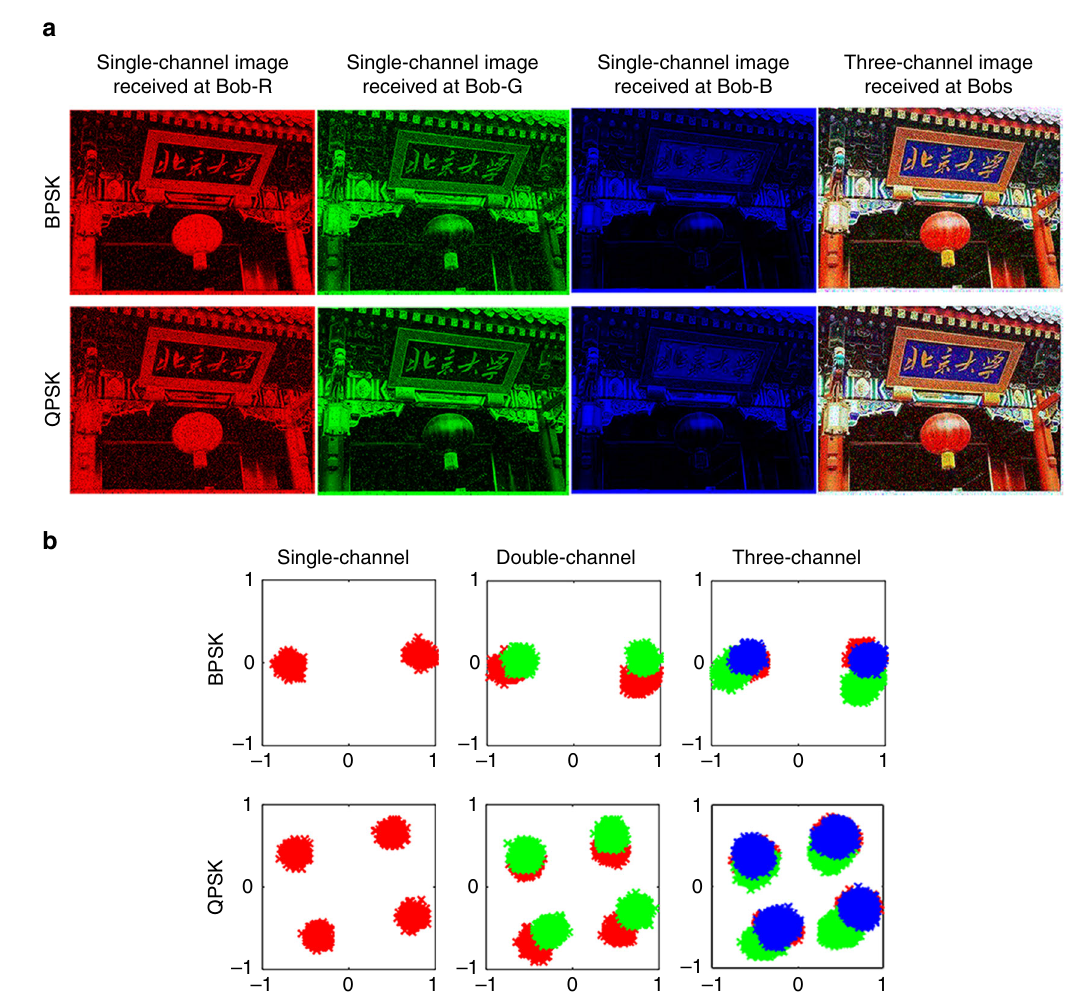
Fig. 5 Results of the BPSK MBWC and QPSK MBWC. a Individual monochrome and synthesized full-color images transmitted from Alice to Bob by MBWC-BPSK and MBWC-QPSK. b Constellation results of MBWC-BPSK and